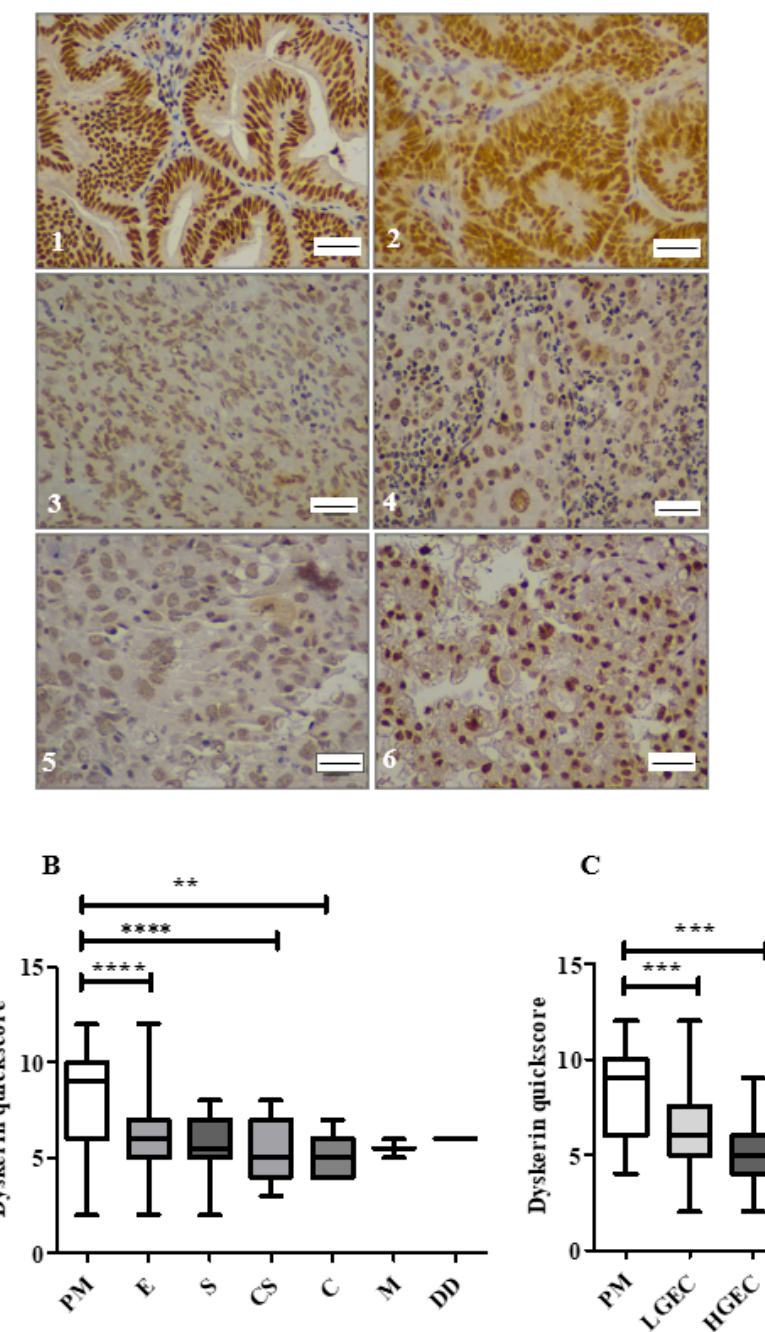
Figure 3. Immunostaining of dyskerin in endometrial cancer subtypes ( n = 109). ( A ) Representative microphotographs of dyskerin in human ECs. ( 1 – 3 ) grade 1–3 endometrioid carcinoma, ( 4 ) serous subtype, ( 5 ) Carcinosarcoma and ( 6 ) clear cell carcinoma. Positive staining appears brown. Magnification 400 × . Scale bar 50 µ m. ( B ) Dyskerin immunoscores in healthy PM ( n = 30) and various EC subtypes including endometrioid (E) ( n = 65), Serous (S) ( n = 12), carcinosarcoma (CS) ( n = 19), clear cell carcinoma ( C ) ( n = 10), mixed cell adenocarcinoma (M) ( n = 2) and dedifferentiated EC (DD) ( n = 1). ** p < 0.01, **** p < 0.0001. Kruskal-Wallis test. ( C ) Dyskerin immunoscores in human endometrial epithelium of healthy PM ( n = 30), LGEC ( n = 53) and HGEC ( n = 56). *** p < 0.001. Kruskal-Wallis